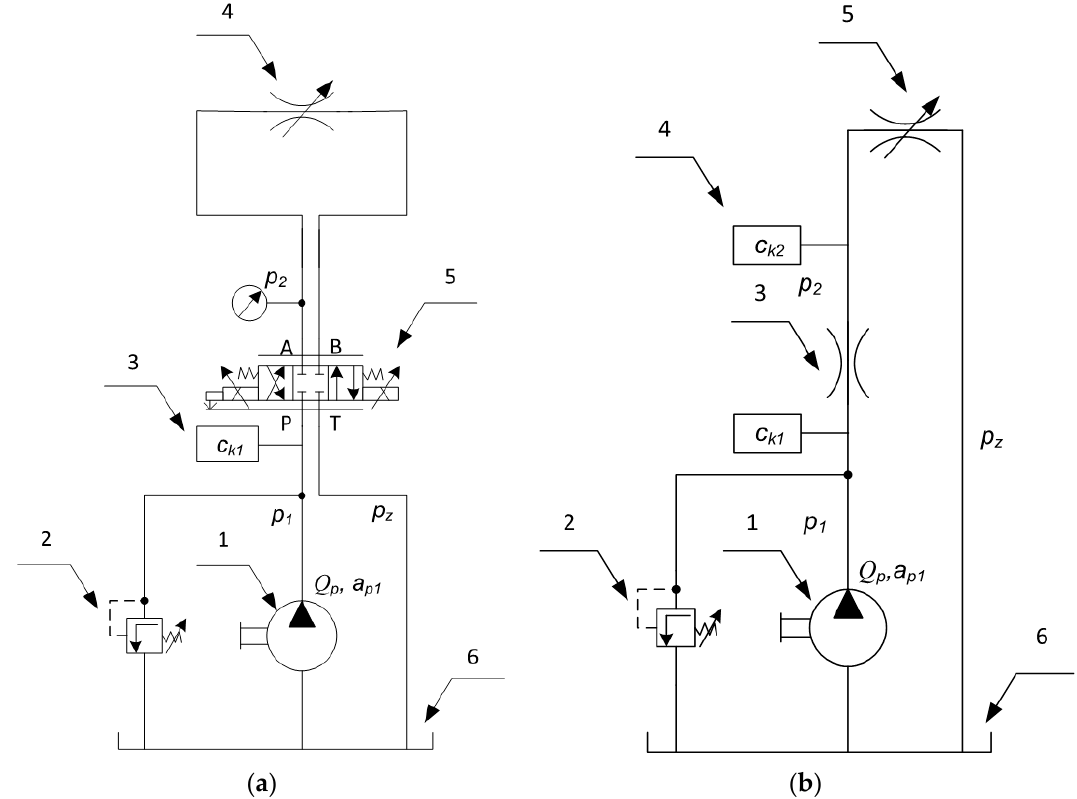
Figure 4. The schematics of the hydraulic system under research: ( a ) scheme of the hydraulic system of the proportional directional valve under test (according to Equation (3)): 1—pump, 2—relief valve, 3—system line capacitance, 4—adjustable throttling valve, 5—proportional directional valve, 6—tank; ( b ) scheme of the hydraulic system described by Equation (4): 1—pump, 2—pressure relief valve, 3—throttling valve, 4—system line capacitance, 5—adjustable throttling valve, 6—tank.